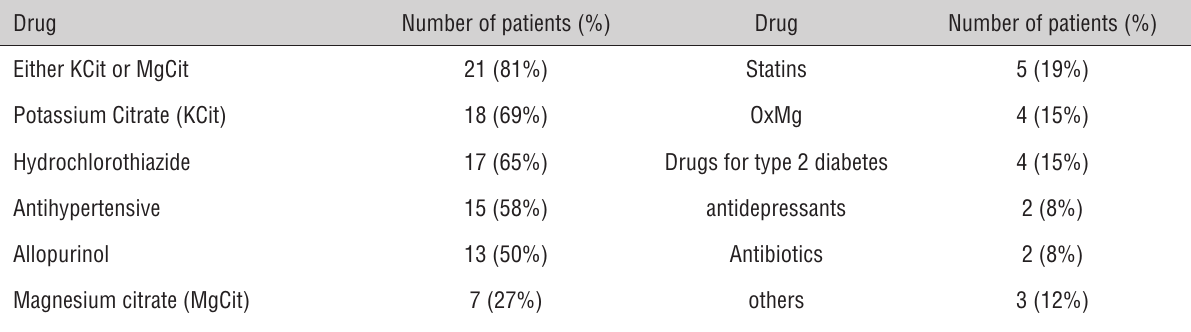
Table 3 - Medications used by patients in the cohort following baseline evaluation. Drug Number of patients (%) Drug Number of patients (%) Either KCit or MgCit